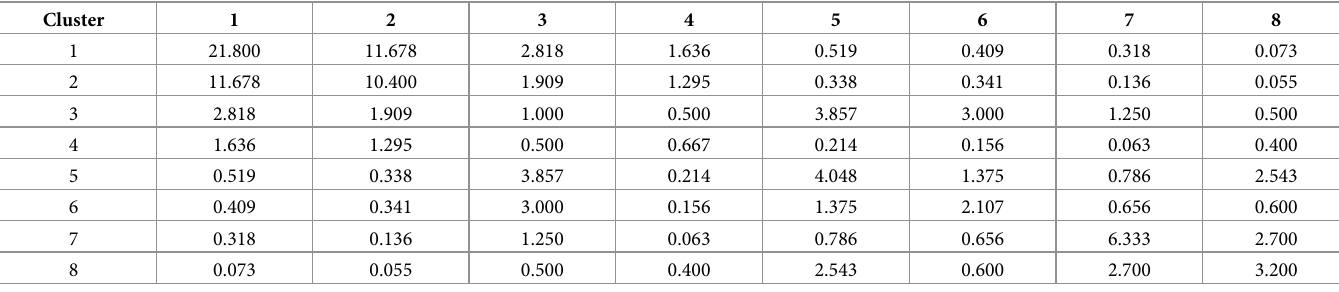
Table 4. IPC correlation module density matrix.